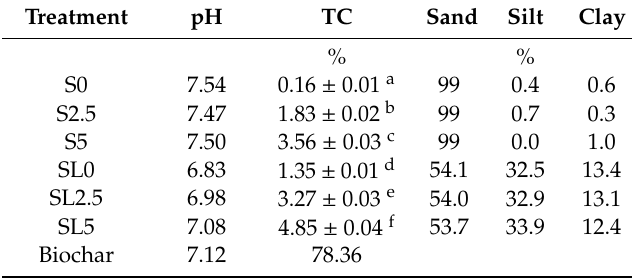
Table 2. Main physical and chemical properties reported in [47]. Particle size distribution is based on the German Standard classification [48].